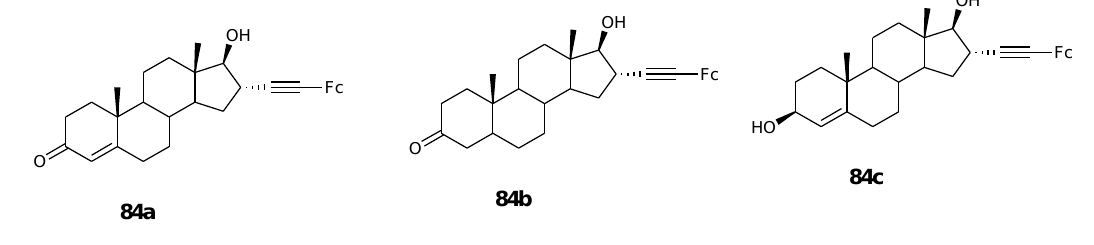
Figure 31. Hybrid compounds 84a – c.